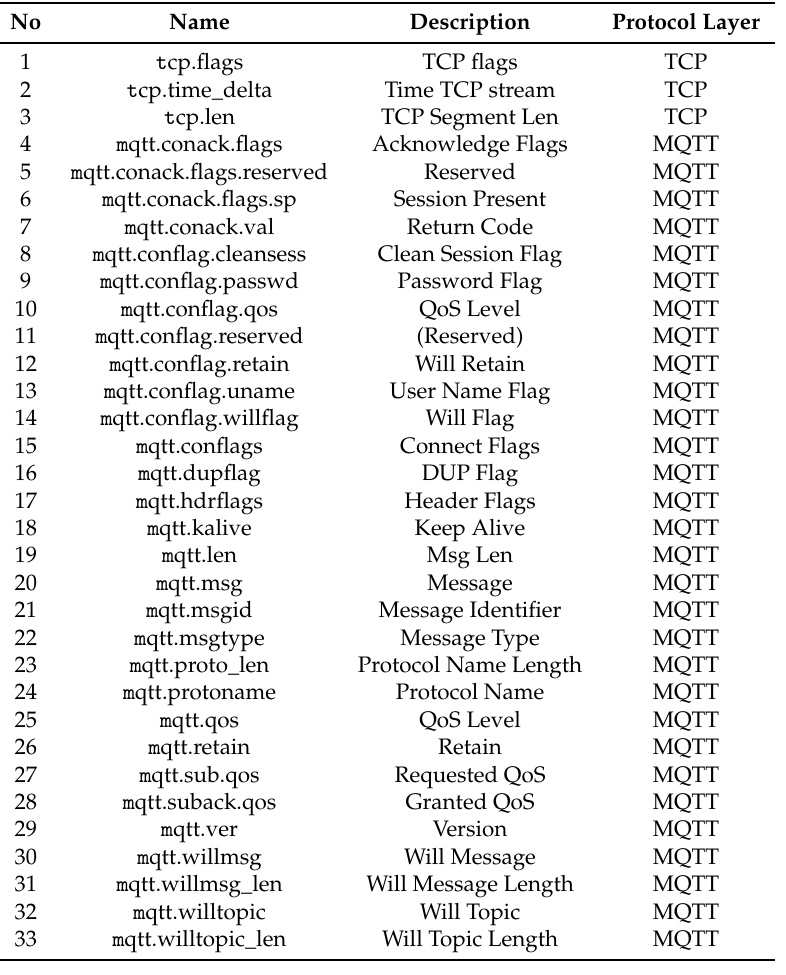
Table 4. The list of extrapolated features.